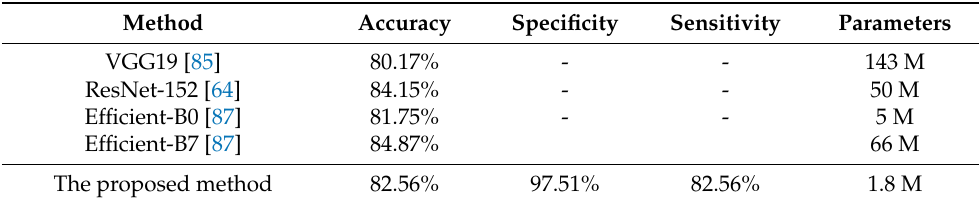
Figure 7. Bar chart results of various methods in the second experiment. Table 6. Comparison with different methods on the ISIC2019 dataset in the third experiment